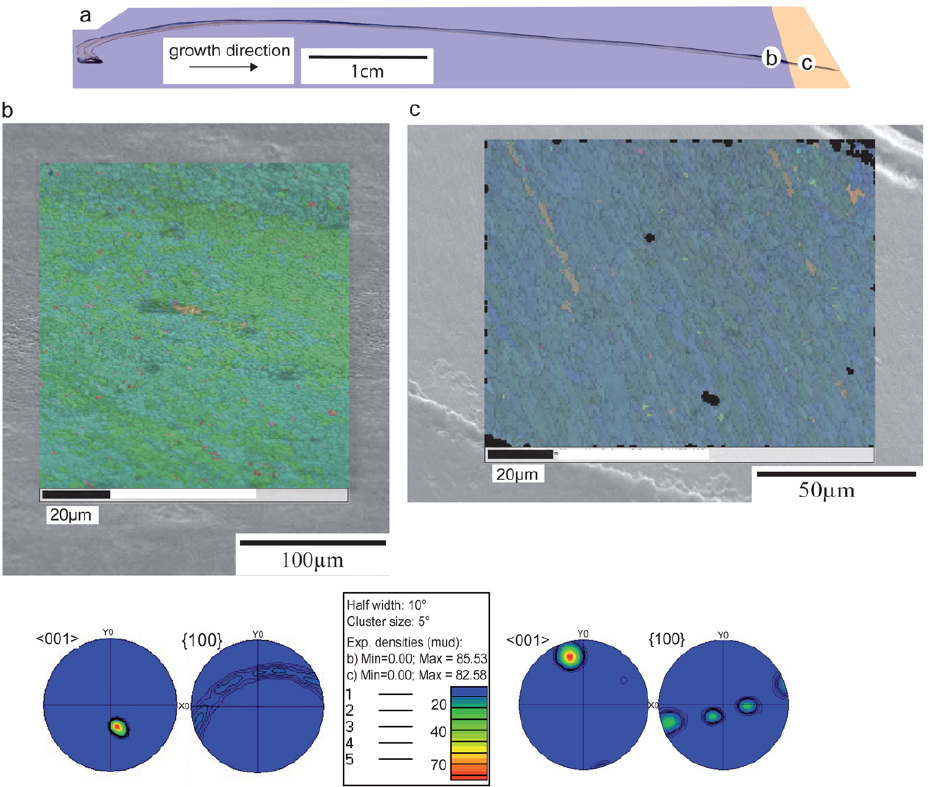
Fig. 6. Thin-section view of M. galloprovincialis from control site C. (a) Blue colour indicates shell precipitated prior to transplantation and orange colour indicates shell precipitated after transplantation to control site. ( b and c ) Electron backscattered diffraction (EBSD) maps and pole figures. Note location of b and c in Fig. 6a. Different colours indicate different orientations of calcite prisms. Black points denote those regions within the shell where Kikuchi patterns could not be indexed. The three RGB colour components code for the three Euler angles of crystal orientation. In order to visualize all patterns the whole range of Euler angles are plotted (Euler 1 between 0–180 ◦ , Euler 2 between 0– 180 ◦ and Euler 3 between 0–120 ◦ ). Note homogenous (green to blue) colours in well structured calcite shell prior to and after transplantation. The differences between the maps are due to different step sizes. Pole figures representing stereographic projections of crystallographic axes and planes. MUD=Multiples of Uniform